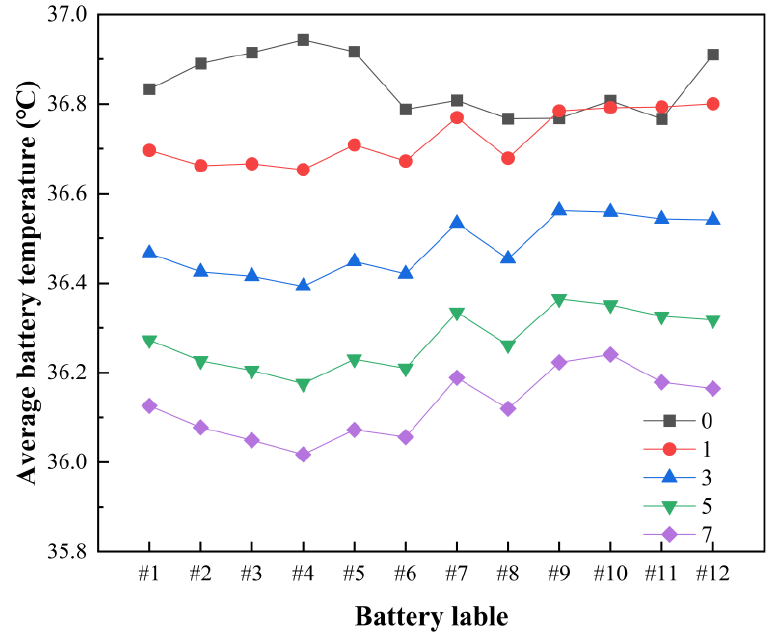
Figure 7. Battery temperature under different numbers of disturbance structures.